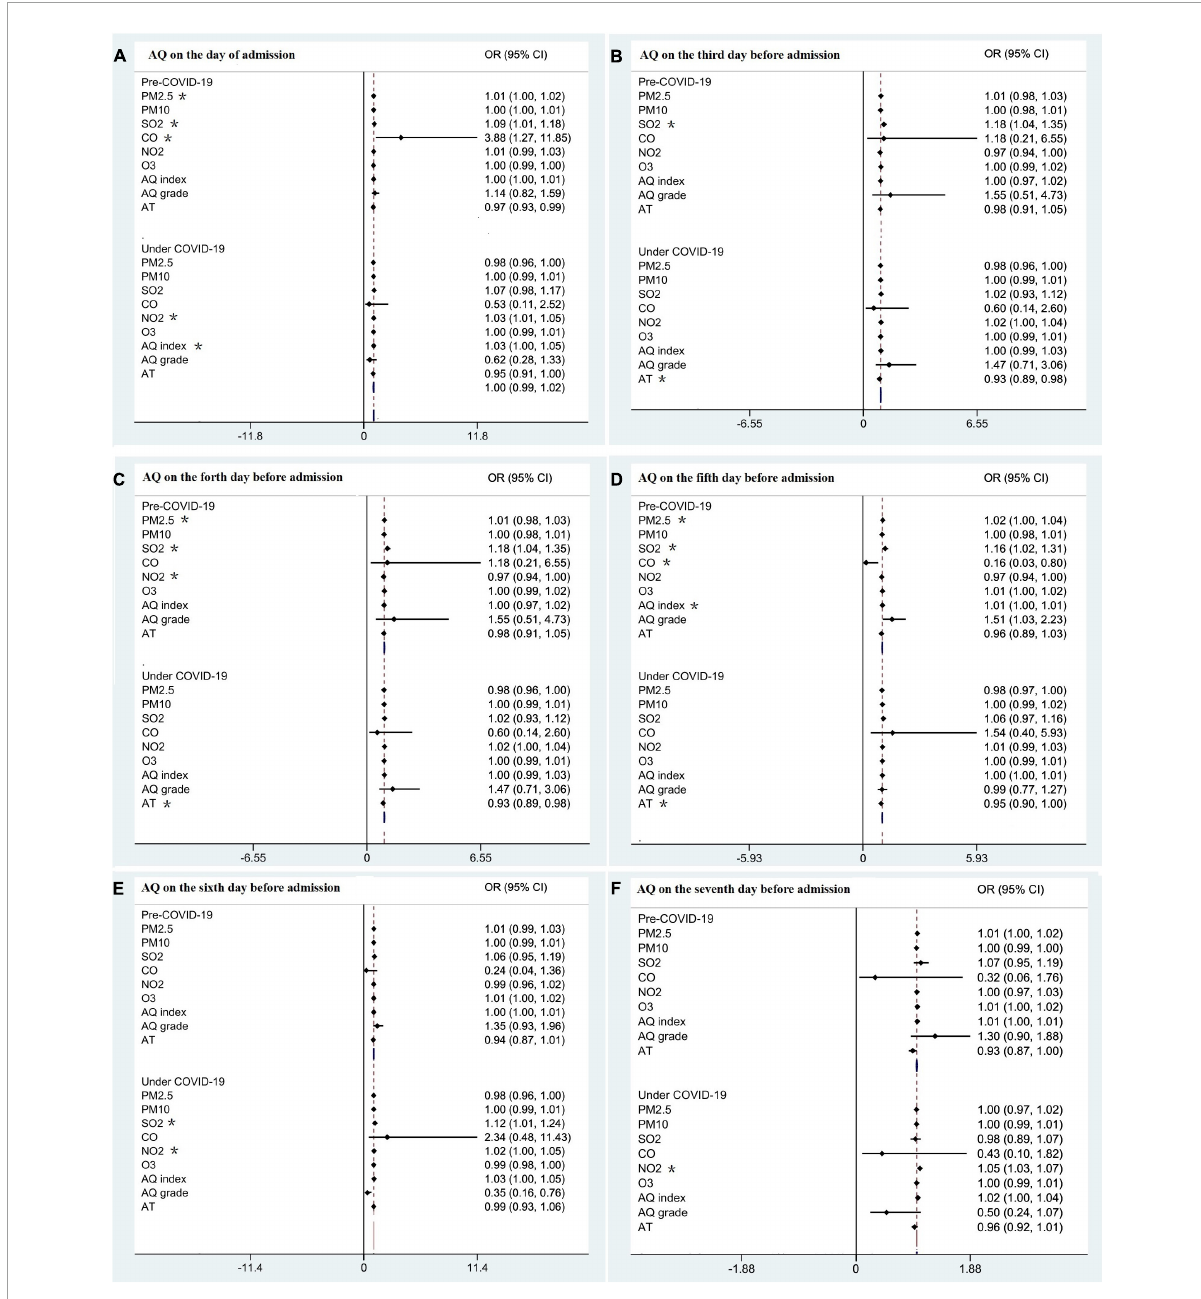
FIGURE3 The effect of AQ on the admission pre and under COVID-19. (A) AQ on the day of admission. (B) AQ on the third before admission. (C) AQ on the fourth before admission. (D) AQ on the fifth before admission. (E) AQ on the sixth before admission. (F) AQ on the seventh before admission. AQ, air quality; OR, odds ratio; CI, confidence interval; PM2.5, particulate matter 2.5; PM10, particulate matter 10; PM25, particulate matter 25; SO 2 , sulfur dioxide; CO, carbon monoxide; NO 2 , nitrogen dioxide; AQ grade: 1 = excellent, 2 = good, 3 = mild pollution, 4 = moderate pollution, 5 = heavy pollution 6 = severe pollution; *indicates a significant result. AT, air temperature.